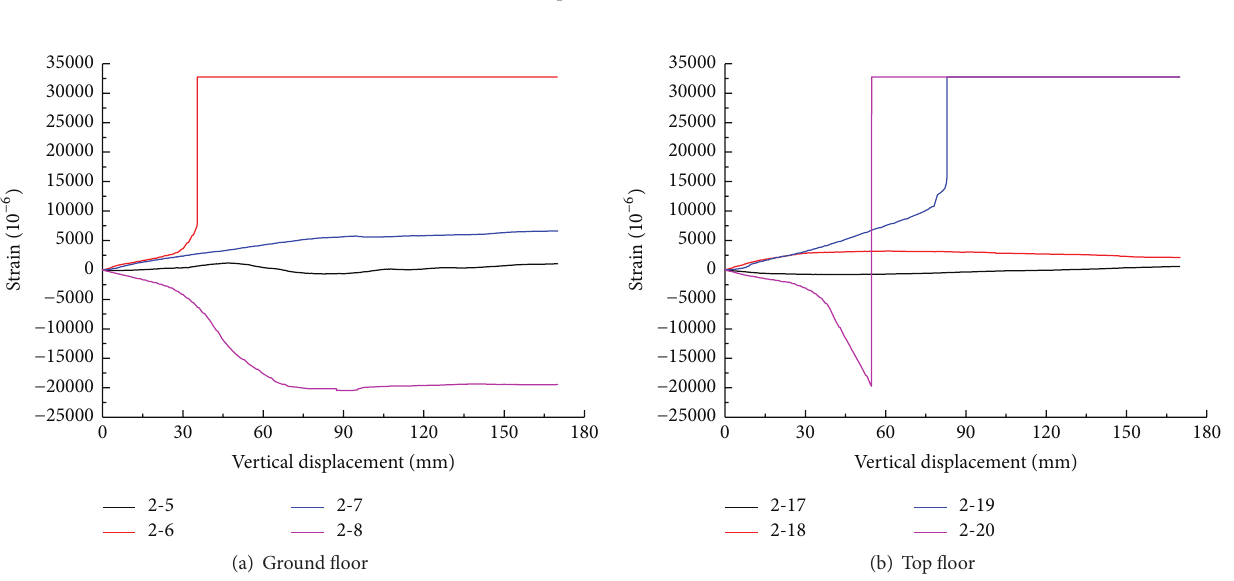
Figure 12: Strain response at the ends of beam A1-B1.